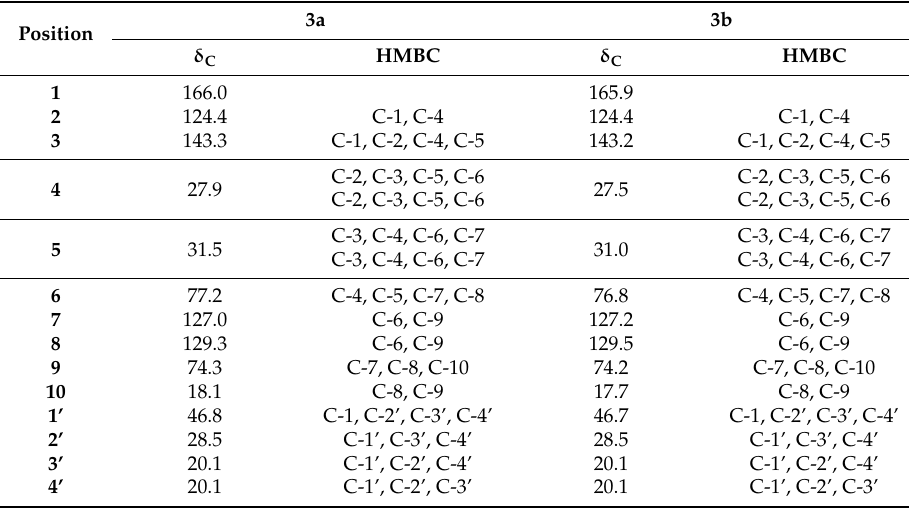
Table 2. 13 C-NMR data (CDCl 3 , 150 MHz) for compounds 3a and 3b